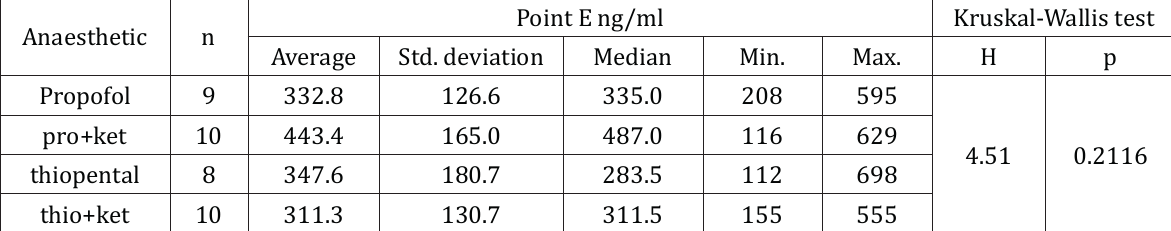
Table 15. Descriptive statistics – Concentration of MMP-9 at the end point of the study among patients treated with different anaesthetics and the result of a Kruskal-Wallis test